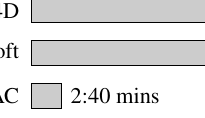
Figure 5. Processing times for generating quick orthophoto mo- saics shown in figure 4. The times include the complete pro- cessing chain, from loading the 254 tiff images up to comple- tion of orthophoto mosaic export.